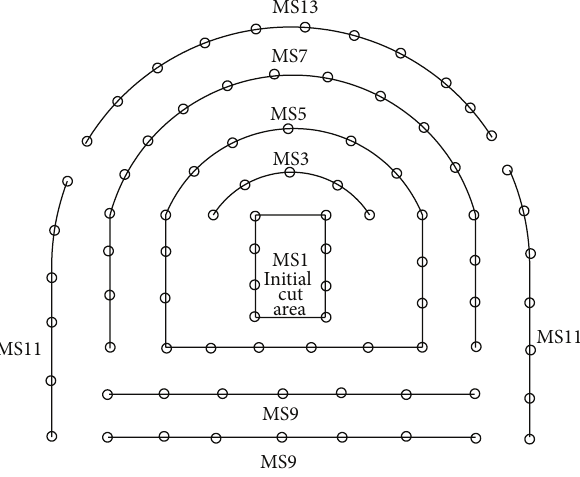
Figure 6: Blasting segmented situation.